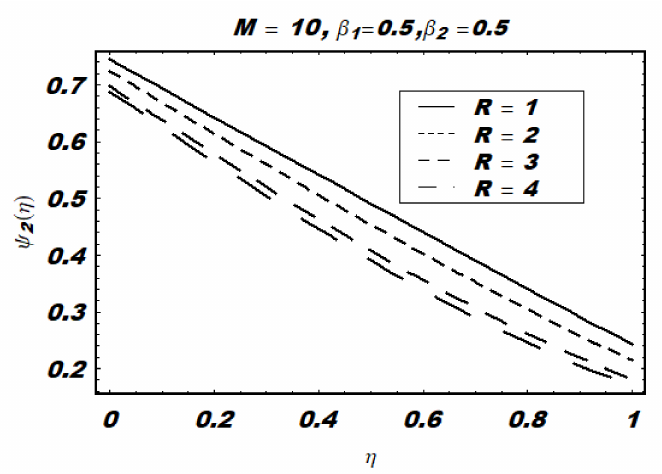
for the long slider. 3